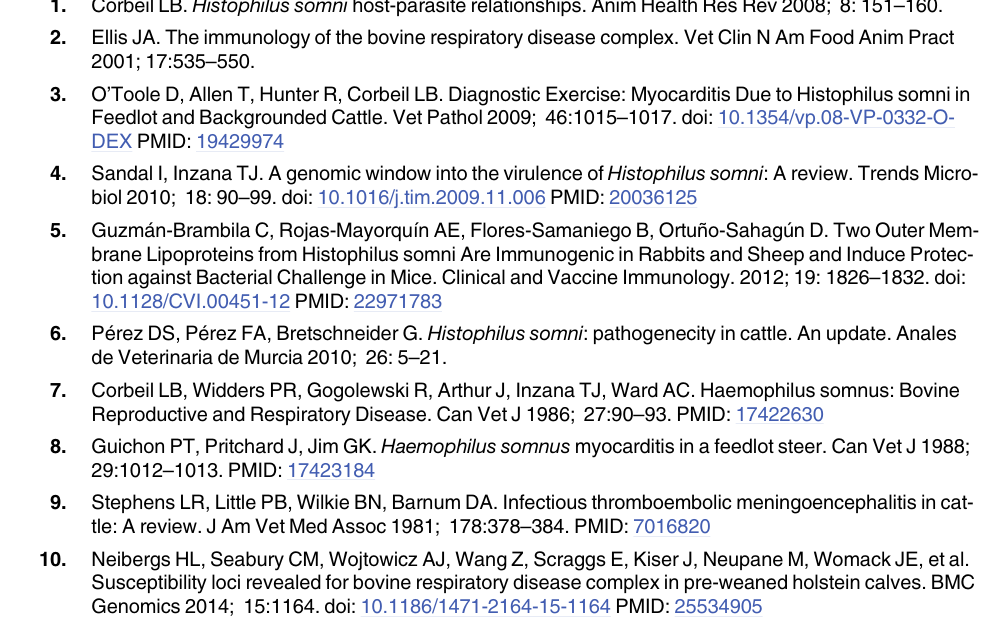
S3 Table. The sum of joint lesions for each animal measured from day 1 to 21 post chal- lenge for all groups: A (non-vaccinated) and B, C, D (vaccinated). S4 Table. Full post-mortem analysis of euthanized animals. Bacteriological analysis carried out on samples of heart, lung, kidney and joints. Positive cultures for H . somni are shown in dark